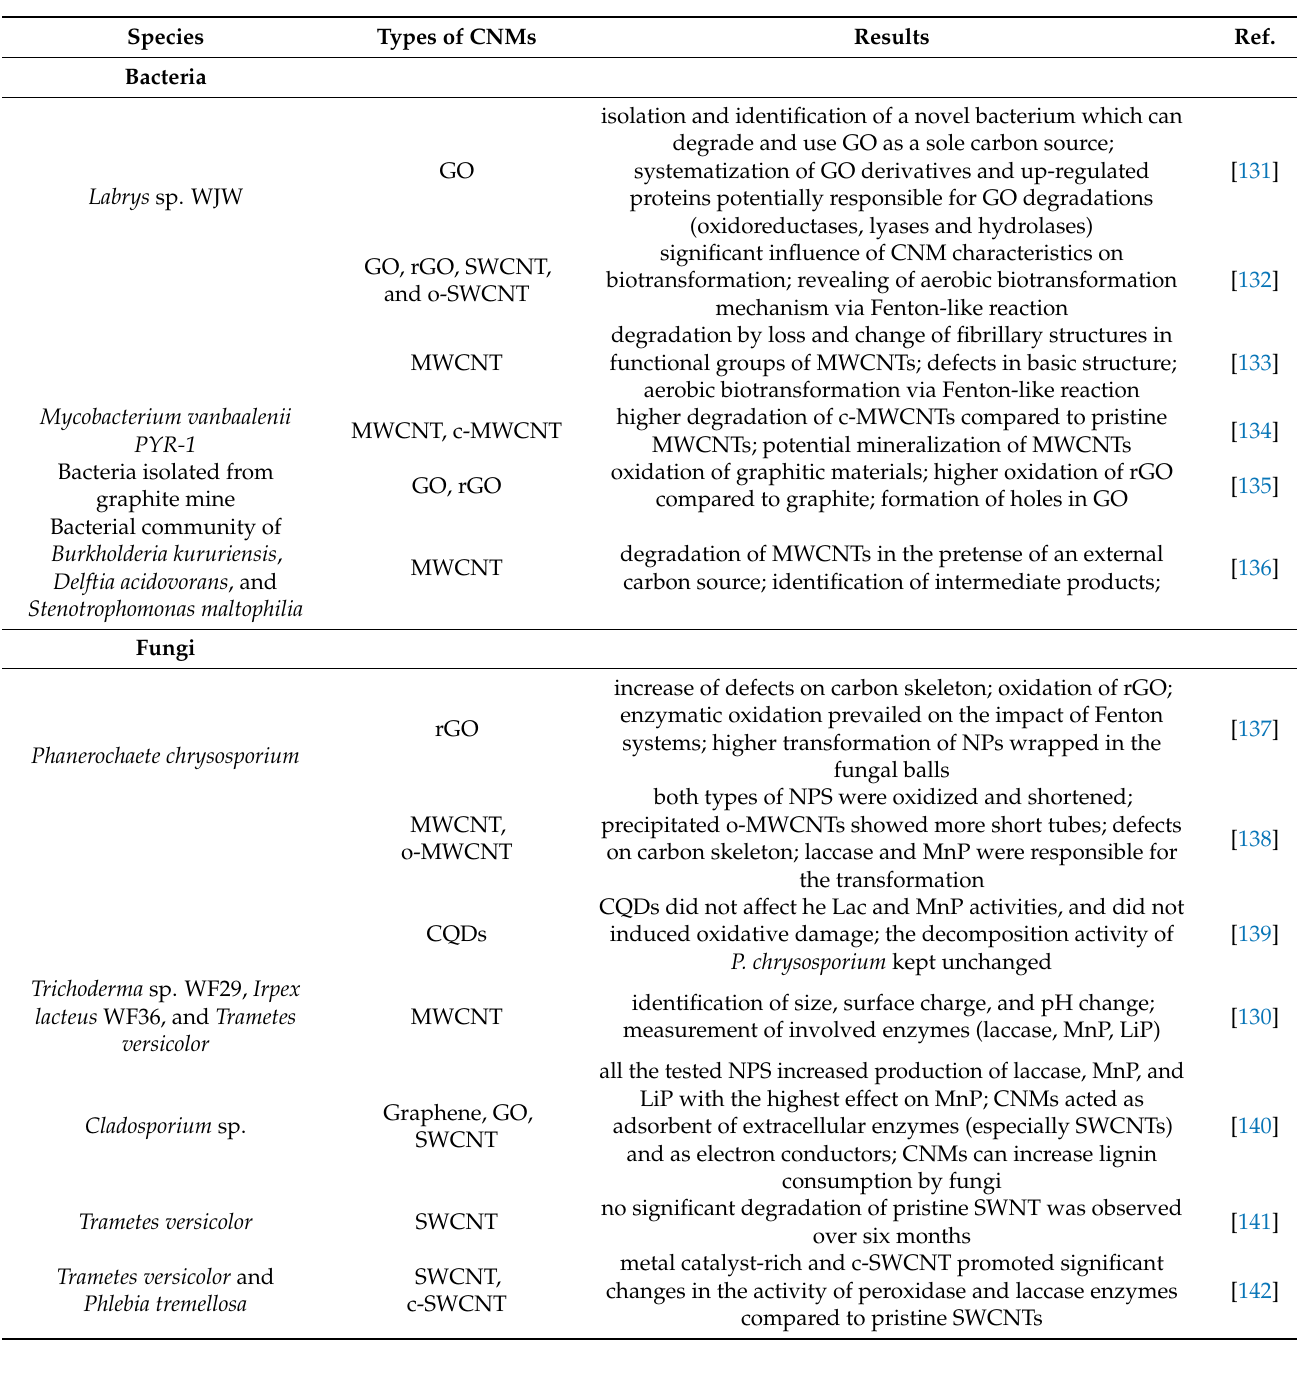
Table 1. The current studies of microbial degradation of